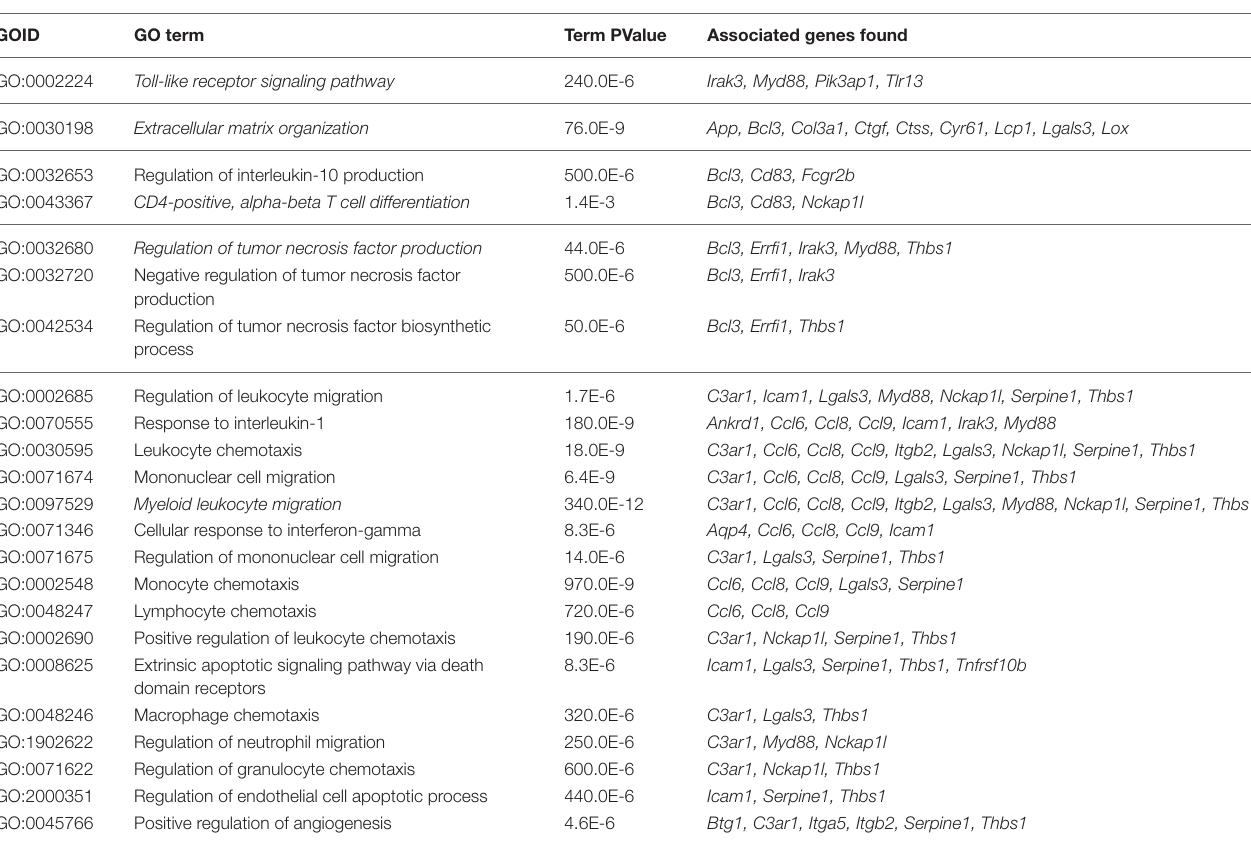
TABLE 4 | Overview of GO terms found by